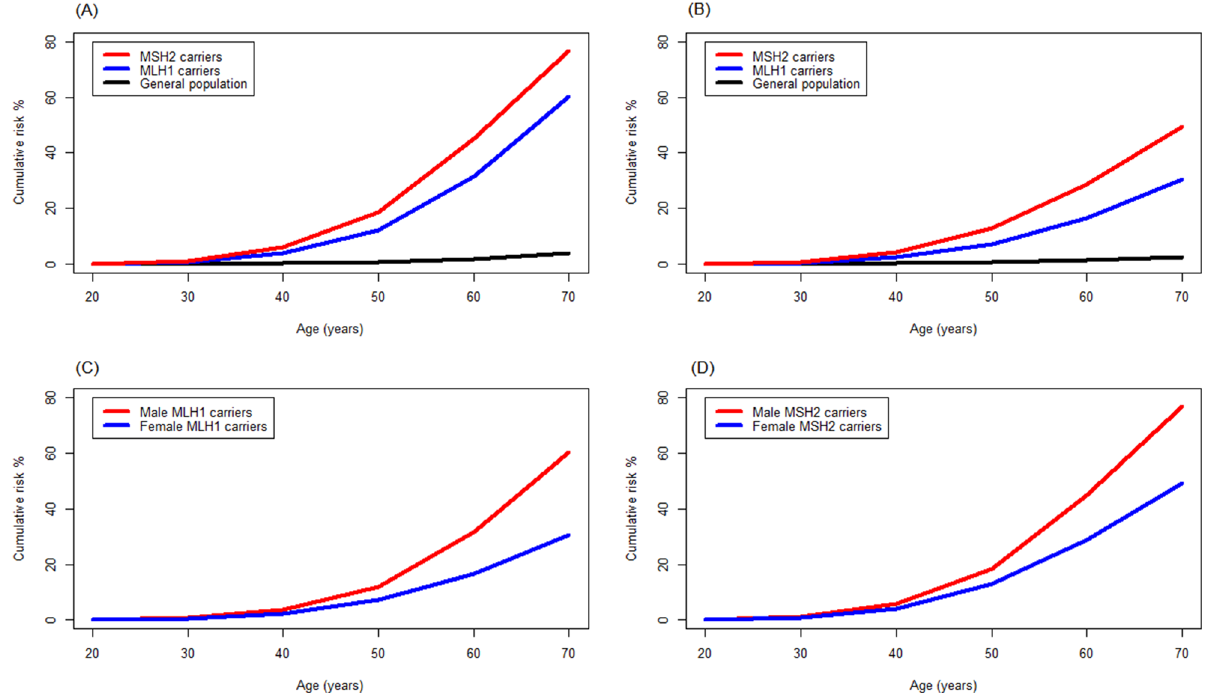
Figure 2. Age- and sex-specific cumulative risk of colorectal cancer (CRC) at the age of 70 years in patients with Lynch syndrome (germline mutations in MLH1 or MSH2 ) in the Han Chinese population in Taiwan. ( A ) CRC risk in male patients with Lynch syndrome compared with the male general population. ( B ) CRC risk in female patients with Lynch syndrome compared with the female general population. ( C ) Comparison of CRC risk between male and female patients with MLH1 mutations. ( D ) Comparison of CRC risk between male and female patients with MSH2 mutations. The figure was produced using R software (version 3.6.2, R Core Team 2019, https:// www.r- proje ct.